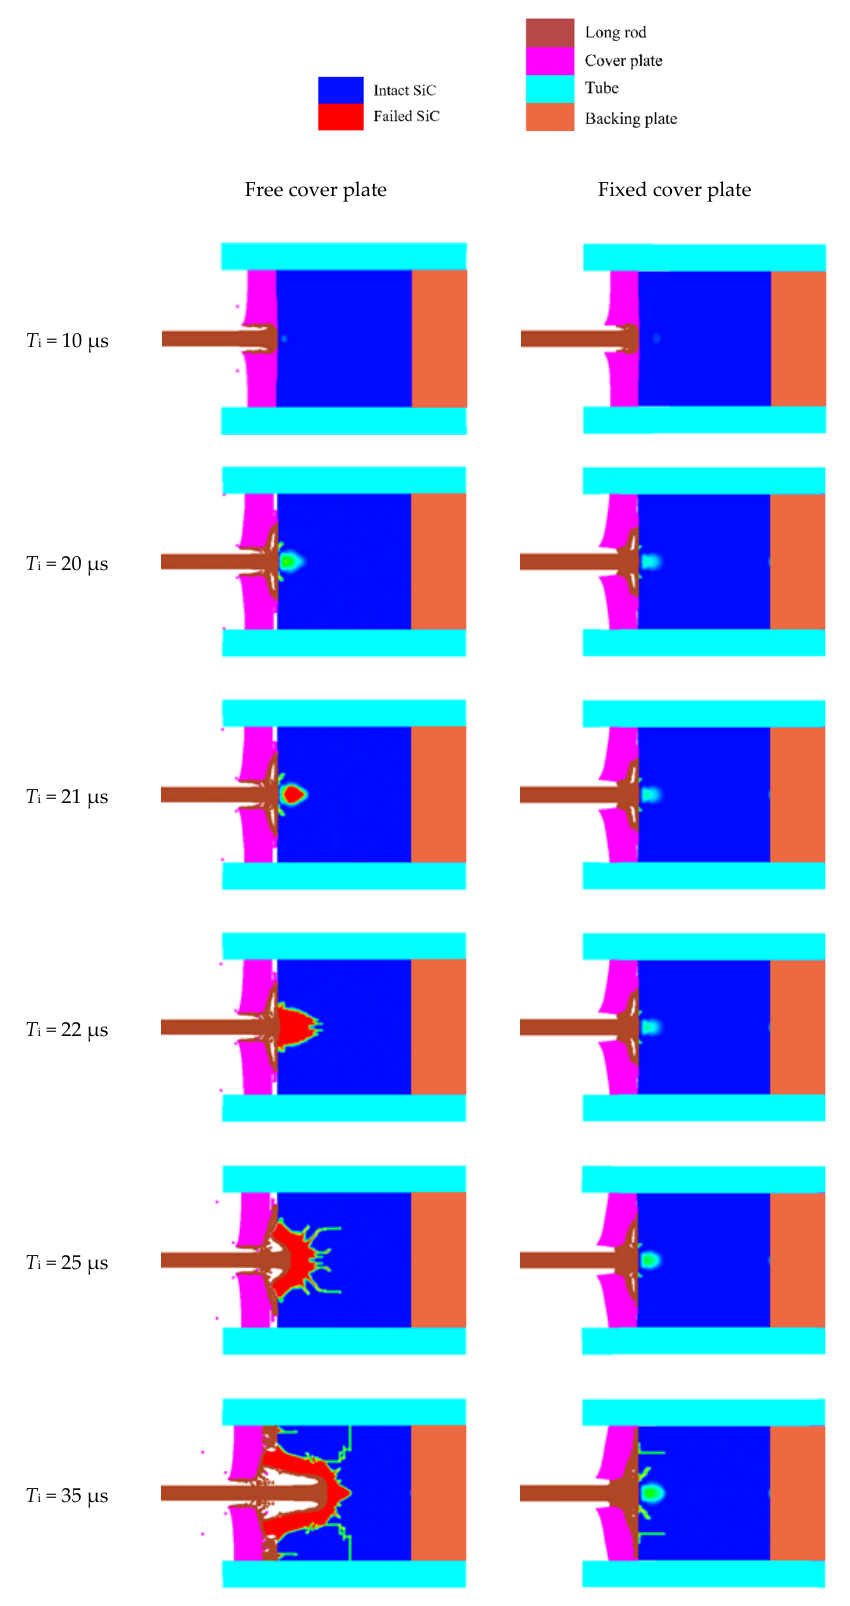
Figure 5. Damage of confined SiC target with the free and fixed cover plates at different time the. The cover plate thickness is 4 mm and the impact velocity is 1250 m/s.